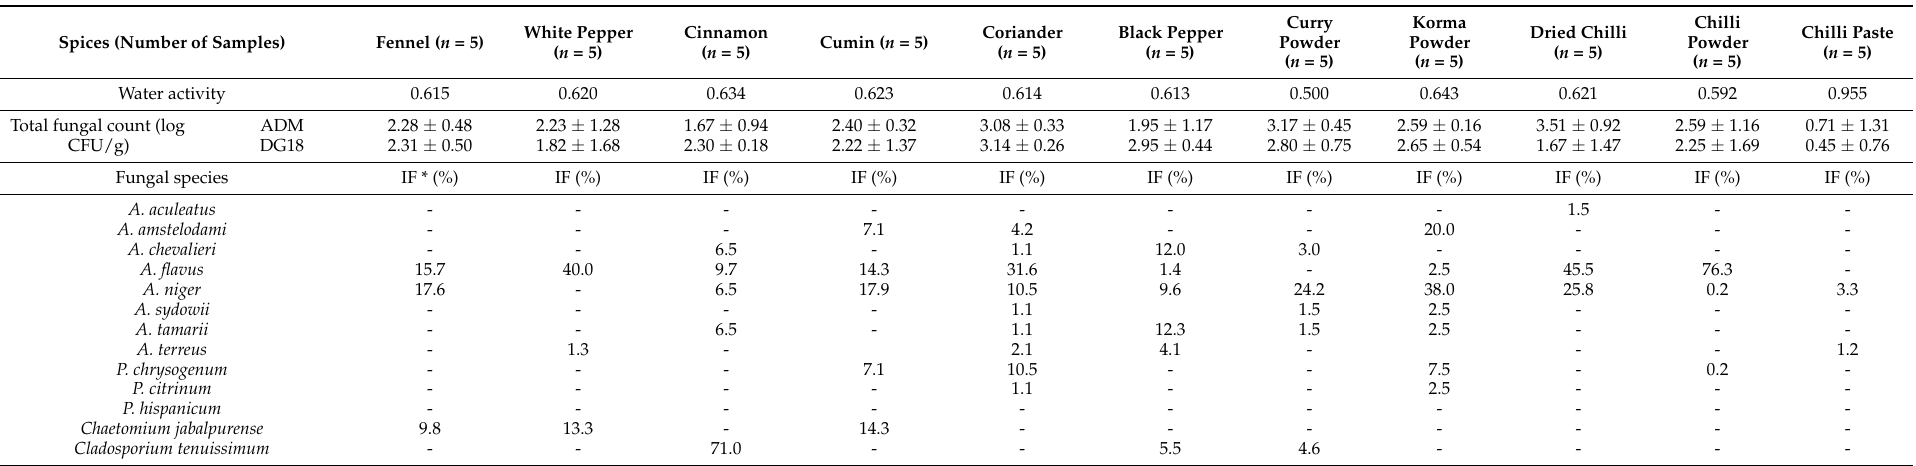
Table 1. Total fungal load and isolation frequency of fungal species from ground